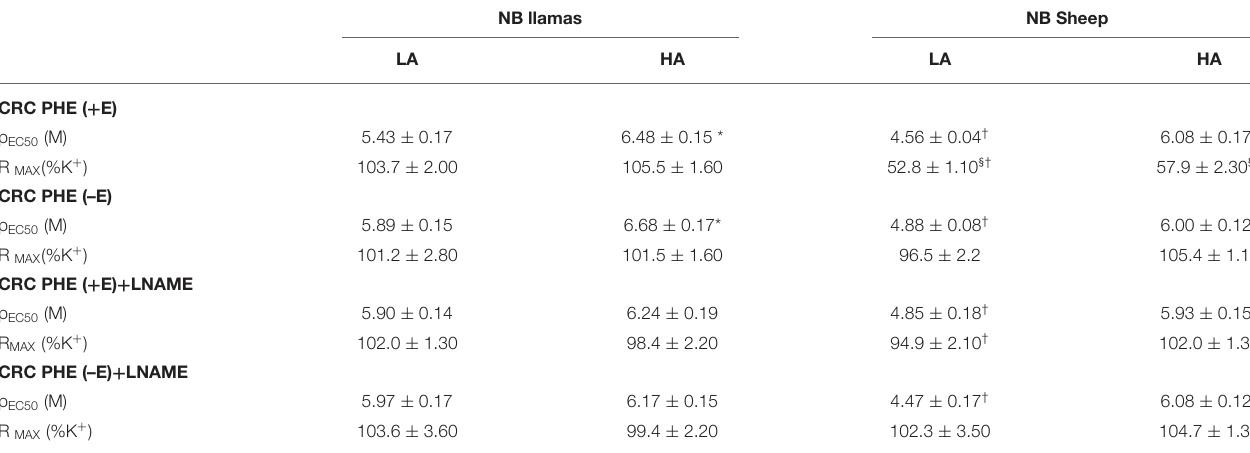
TABLE 2 | Effect of L-NAME blocked and denudation of small femoral arteries in NB LL and NBSH at LA and HA. NB llamas NB Sheep